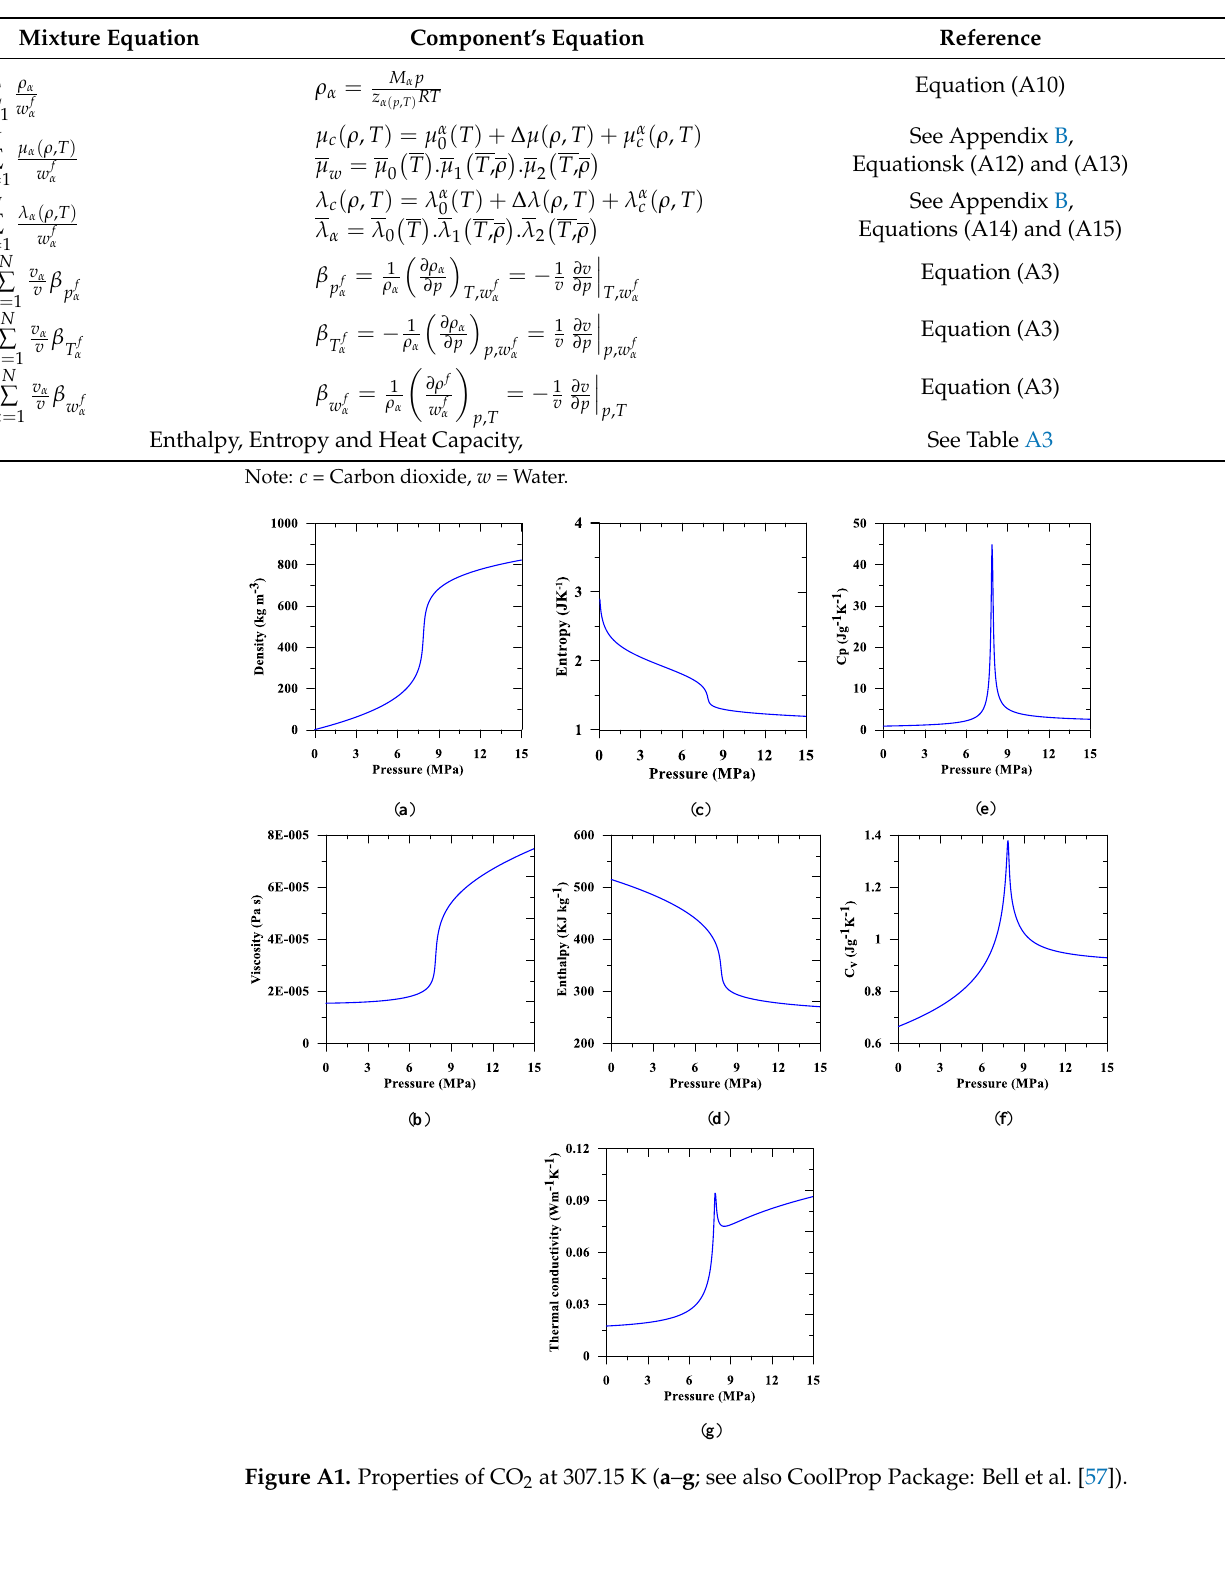
Table A3. Properties of mixture and components.